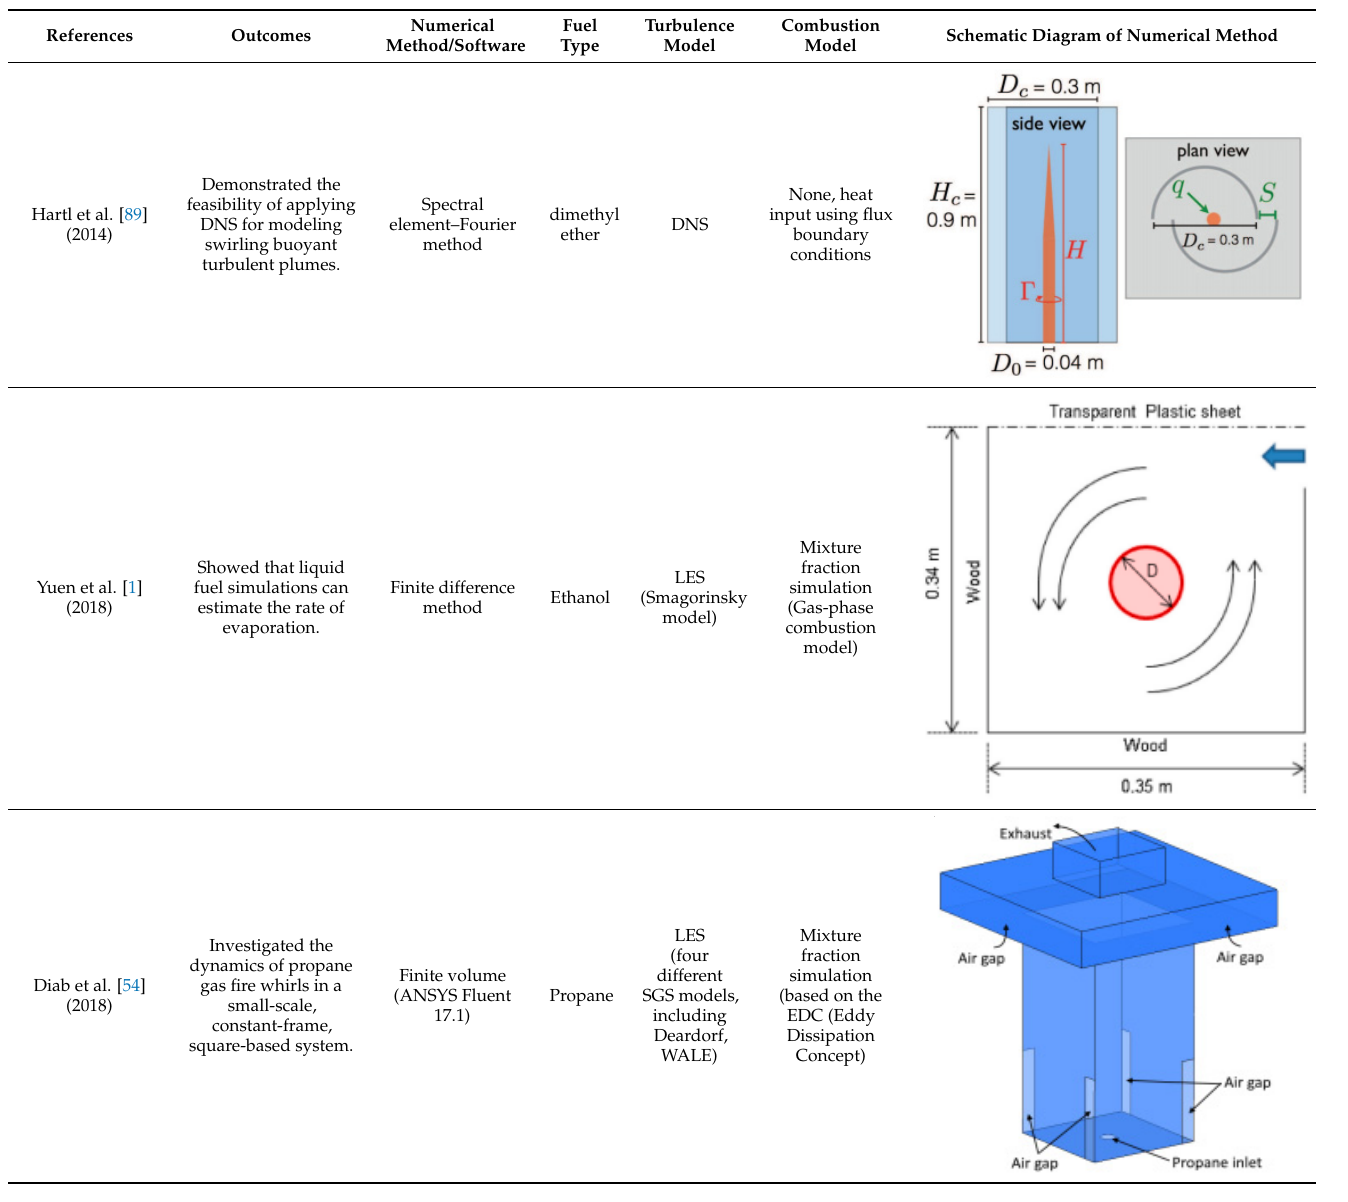
Table 3. Recent numerical analyzed fire whirls and presenting their simulations.